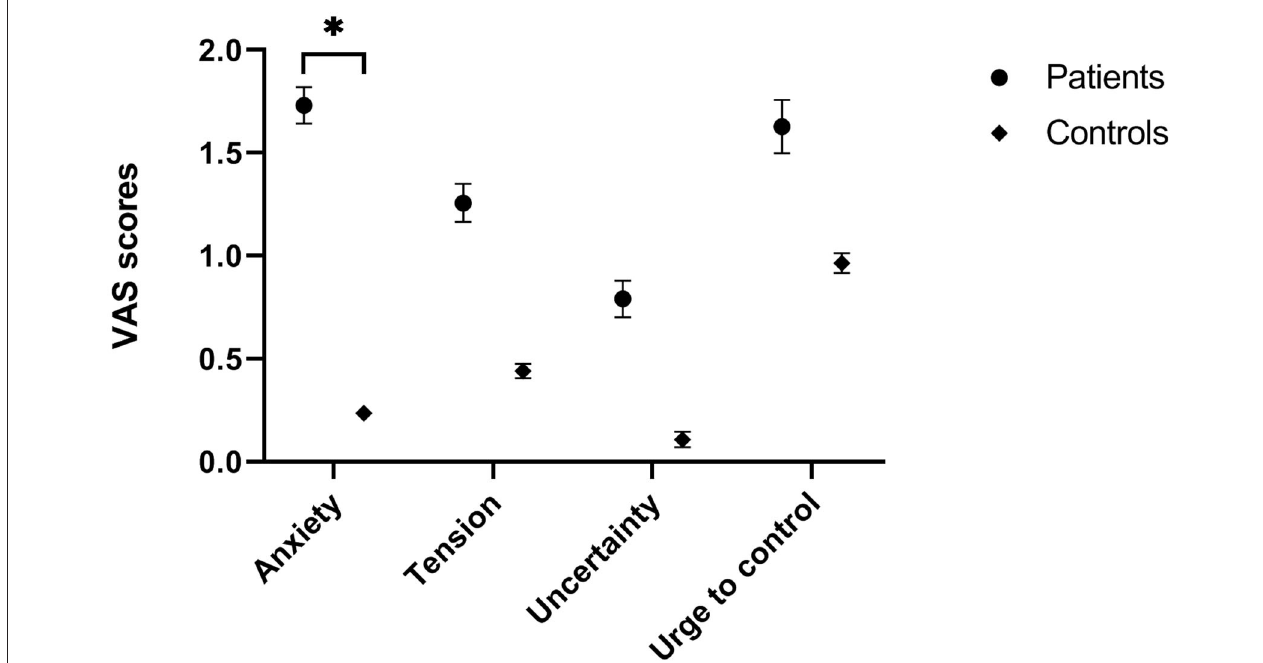
FIGURE 2 | Emotional responses (mean and SE) compared to baseline during VR